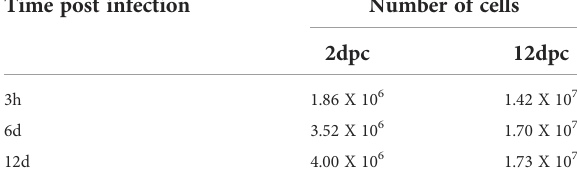
TABLE 3 Number of 3T3-L1 cells at different time-points. HAdV-36- infected at 2 and 12 days dpc in MDI. Time post infection